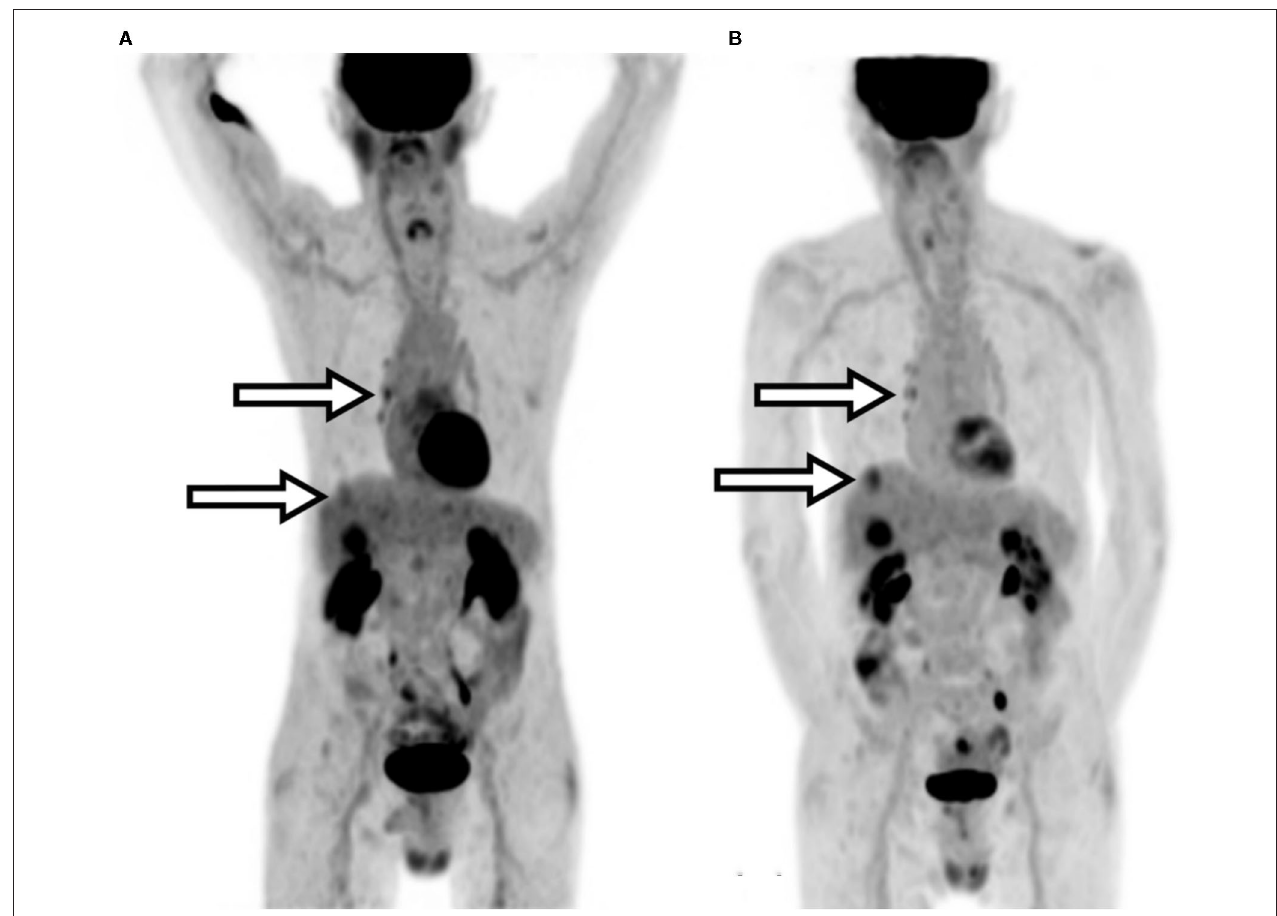
FIGURE 4 | Patient D MIP images. (A) Extravasated injection. (B) Repeated imaging. Arrows indicate the areas of clinically relevant increased